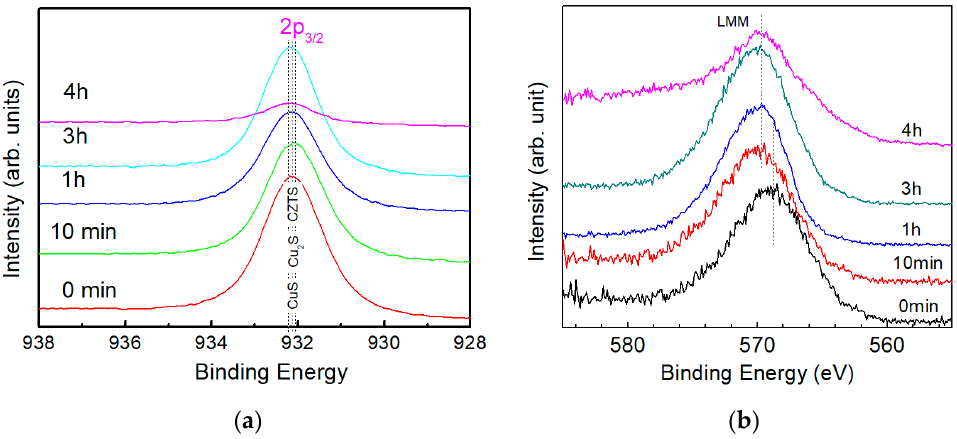
Figure 4. ( a ) XPS spectra of Cu 2p 3 / 2 and ( b ) Auger electron spectra of the Cu LMM of a CZTS film. Dotted lines in ( a ) indicate the peak positions of Cu 2 S, CuS and CZTS and in ( b ) indicate peak positions of the spectra.